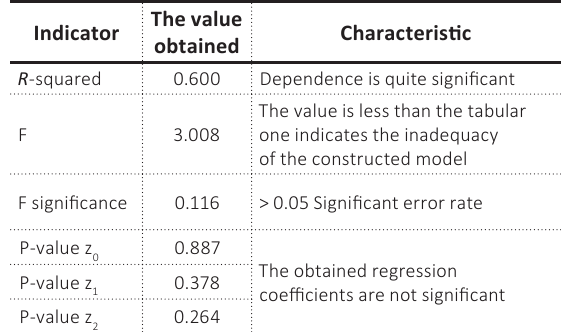
Table 4. The obtained values for calculating